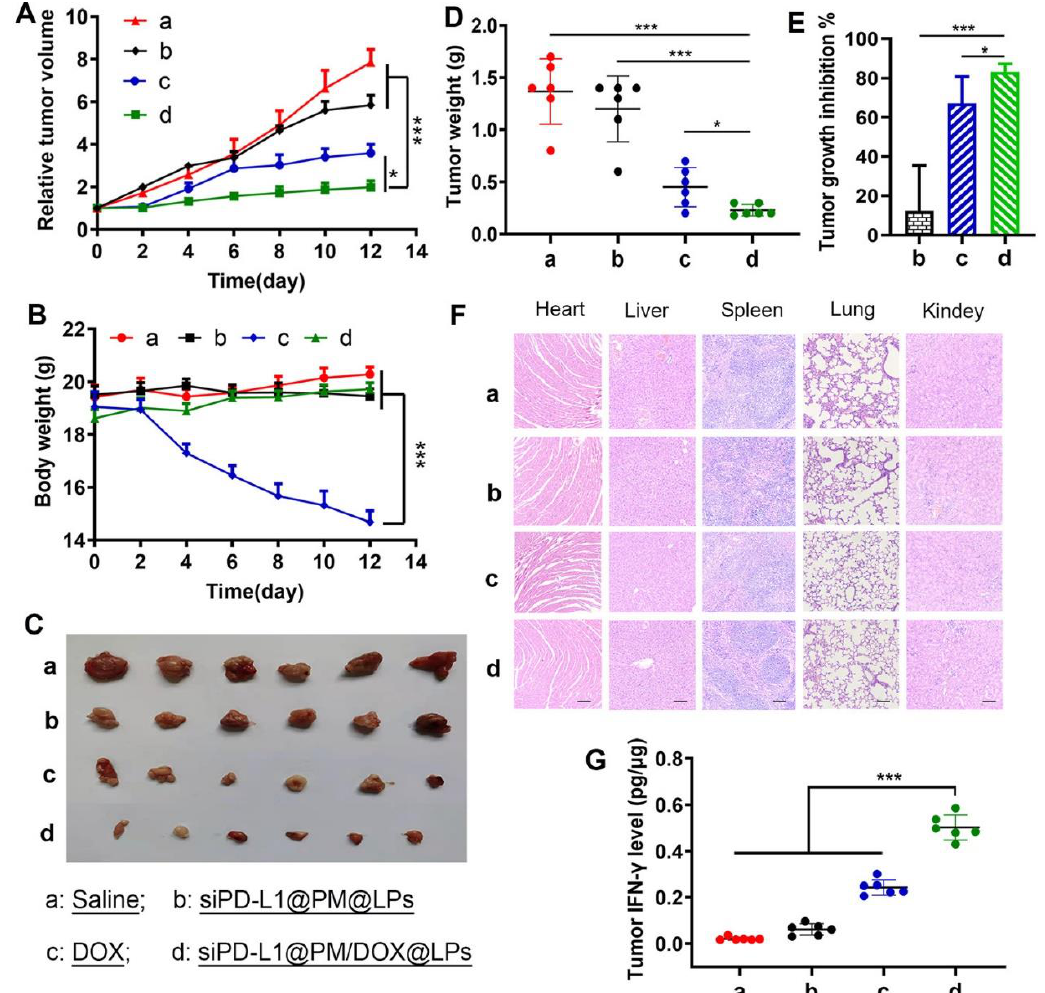
Figure 5. Antitumor effects in vivo (( a ) saline; ( b ) siPD-L1@PM@LPs; ( c ) free DOX; and ( d ) siPD- L1@PM/DOX@LPs). ( A ) Tumor growth curve. ( B ) Weight change during the experiment. ( C ) Pictures of tumor tissues isolated after the completion of the experiment. ( D ) Tumor weight change curve with time. ( E ) Tumor growth inhibition rate under different conditions. ( F ) H&E stain images of major organs (scale bar: 50 µ m). ( G ) Levels of cytokine IFN- γ in tumor tissues [199]. * p ≤ 0.05, *** p ≤